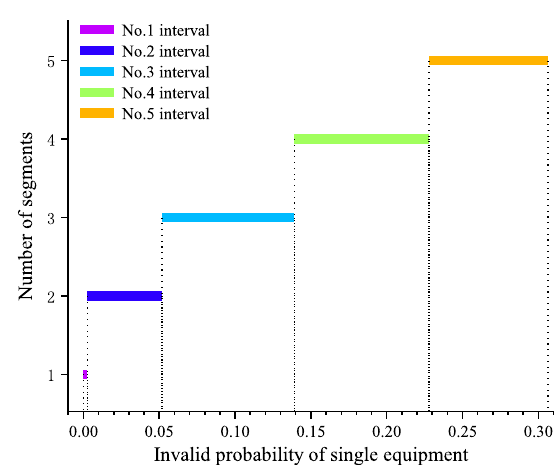
Fig. 6 The relationship between probability and segmentation